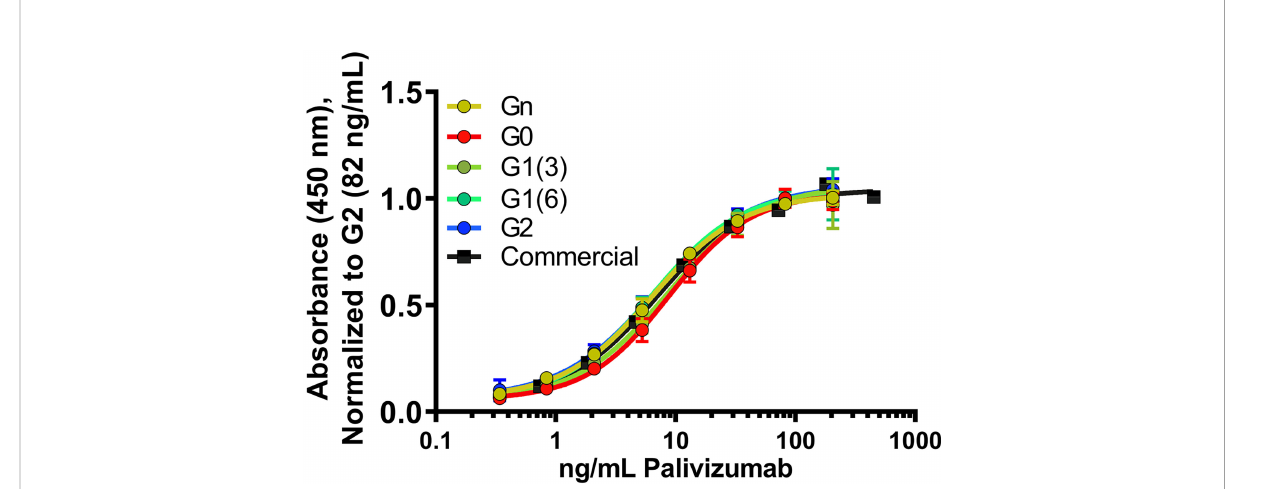
FIGURE 2 Fab binding of glycan-remodeled palivizumab to RSV-A2 F-protein is not affected by remodelled Fc-glycans. Comparable dose-response curves are obtained in the various glycoform analogues in an ELISA assay. RSV-A2 F-protein was coated at 0.25 m g/mL, followed by mAb binding. An anti-human Fc-HRP and Ultra-TMB were used for detection at 450 nm. Error bars show mean ± standard deviation (n=3 replicates); non-linear regression (4-PL) was used for curve- fi tting in GraphPad. EC50 values generated and statistically analyzed (One-way Anova, Tukey post-hoc analysis) by GraphPad showed no signi fi cant differences between the various groups (p =